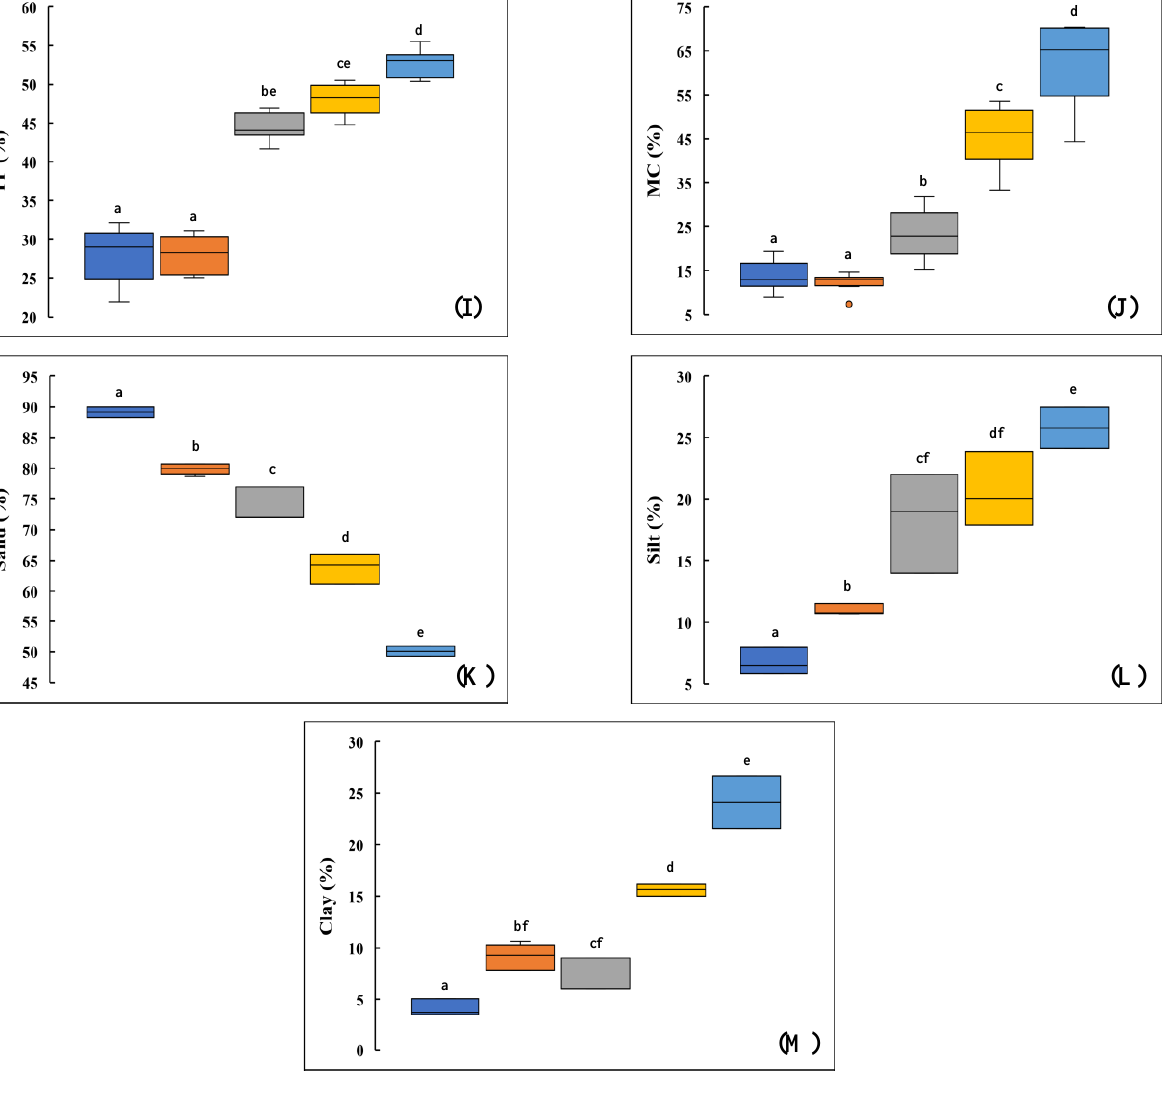
Figure 5. Soil physico–chemical properties in landslide–affected sites (L 6 , L 16 , L 21 and L 26 ) and reference site (Control). ( A ) pH, ( B ) electrical conductivity (EC), ( C ) soil organic carbon (SOC), ( D ) mineralisable nitrogen (MN), ( E ) available phosphorus (AP), ( F ) available potassium (AK), ( G ) bulk density (BD), ( H ) particle density (PD), ( I ) total porosity (TP), ( J ) moisture content (MC), ( K ) sand, ( L ) silt, ( M ) clay. Different letters represent significant difference at p < 0.05 (Tukey’s post hoc HSD test).